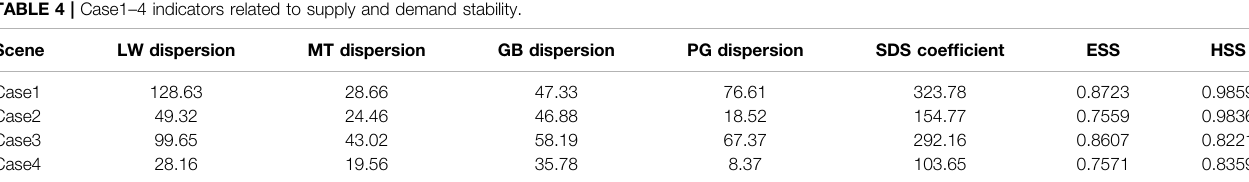
TABLE 4 | Case1 – 4 indicators related to supply and demand